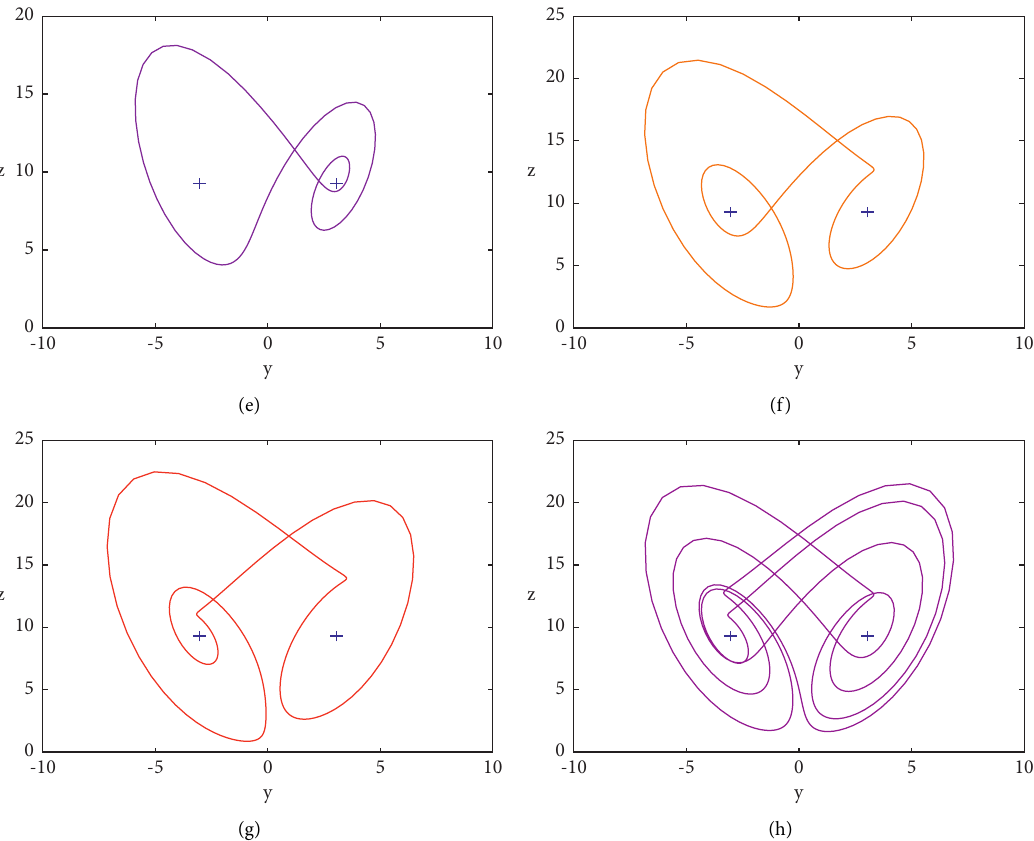
Figure 8: Unstable periodic orbits in the Rucklidge system for ( a,b ) � ( 2 , 9 . 3 ) : (a) cycle 2, (b) cycle 01, (c) cycle 03, (d) cycle 23, (e) cycle 011, (f) cycle 021, (g) cycle 023, and (h) cycle